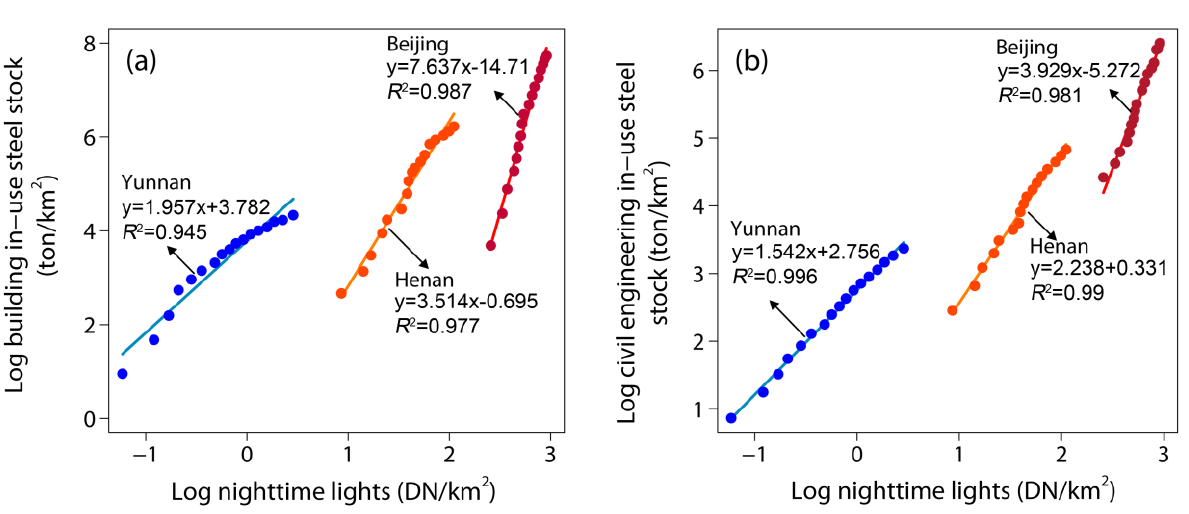
Figure 5. Scatter plots for time-series variables in Beijing, Henan, and Yunnan: ( a ) nighttime lights versus IUSSB; ( b ) nighttime lights versus IUSSCE. Solid lines in blue, orange, and red are regression